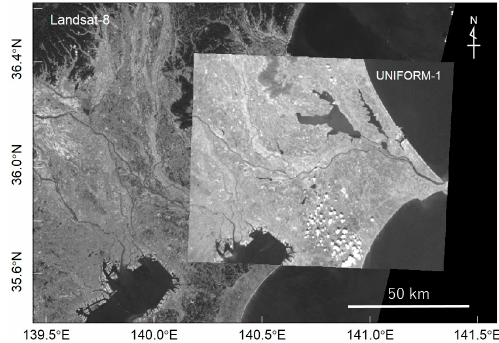
Figure 1. Example of map projection of a VIS image onto latitude–longitude coordinates. The attitude information is deduced from the onboard sensors alone (a gyroscope, a magnetic sensor, and Sun sensors) without the STT. The contrast of the VIS image is enhanced. The background image (base map) is taken from Landsat-8 OLI images (Band